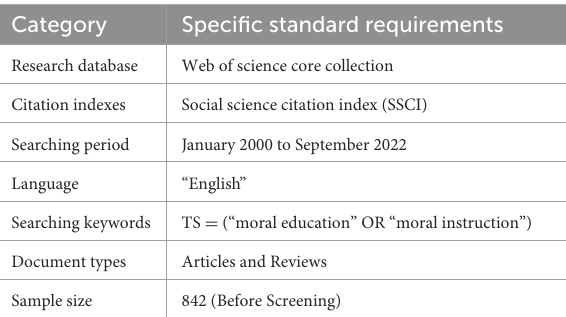
TABLE 1 Summary of data source and